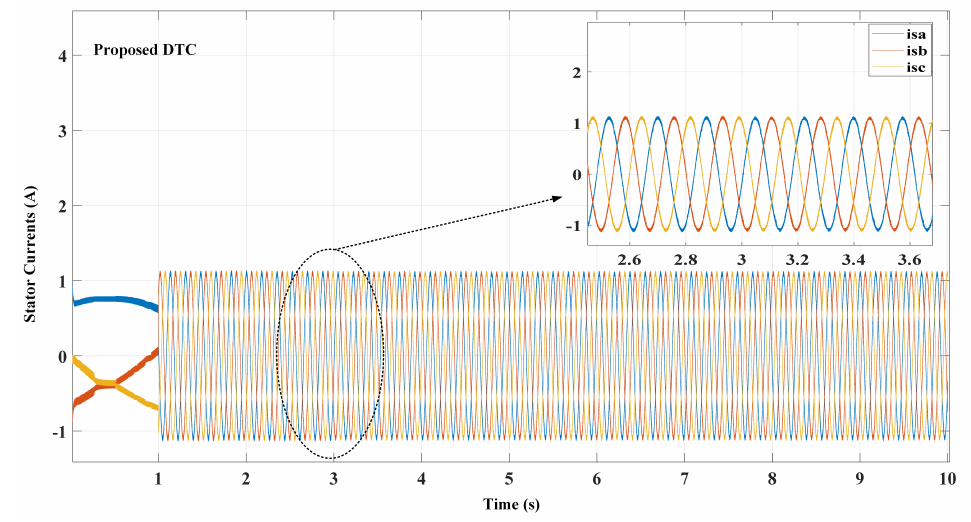
Figure 18. Stator currents of the proposed method for very low speed 5